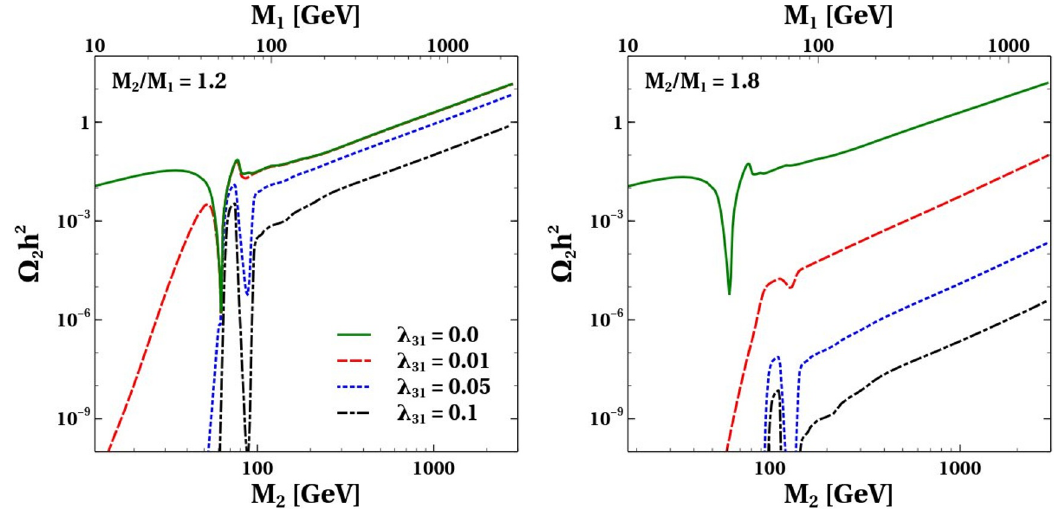
Figure 3 . The e(cid:11)ect of (cid:21) 31 on (cid:10) 2 for two di(cid:11)erent values of M 2 =M 1 : 1 : 2 (left panel) and 1 : 8 (right